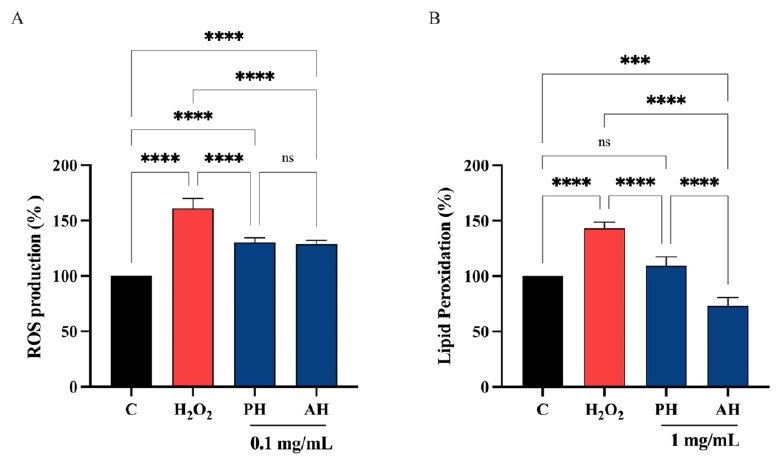
Figure 9. ( A ) Modulation of intracellular H 2 O 2 -induced ROS levels after the pretreatment with PH and AH hydrolysates. Modulation of H 2 O 2 -induced lipid peroxidation after pretreatment with PH and AH hydrolysates ( B ). Data represent the mean ± s.d. of six independent experiments, and each experiment was performed in triplicate. All data sets were analyzed by one-way ANOVA followed by Tukey’s post hoc test. C, control sample; ns, not significant; (***) p < 0.001, (****) p <